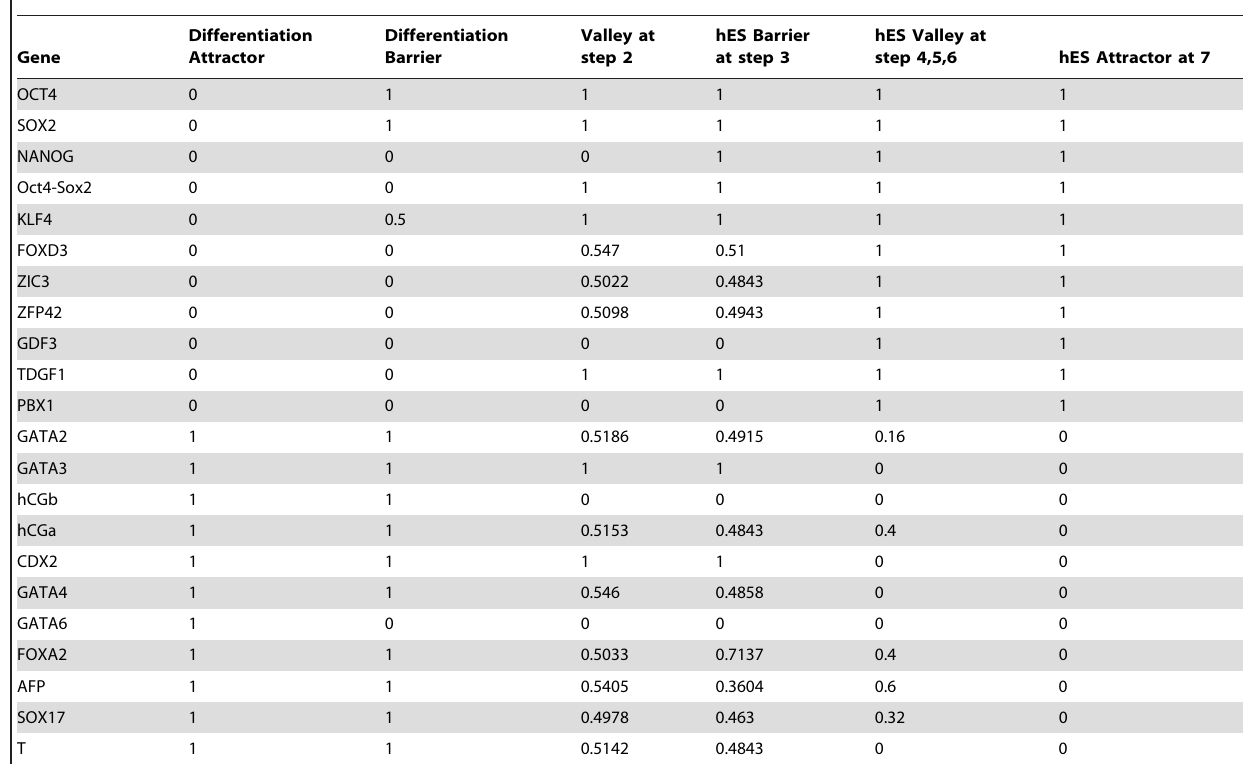
Table 6. Transition states (expression levels) during reprogramming using the five experimental recipes plus GATA6 knockdown.